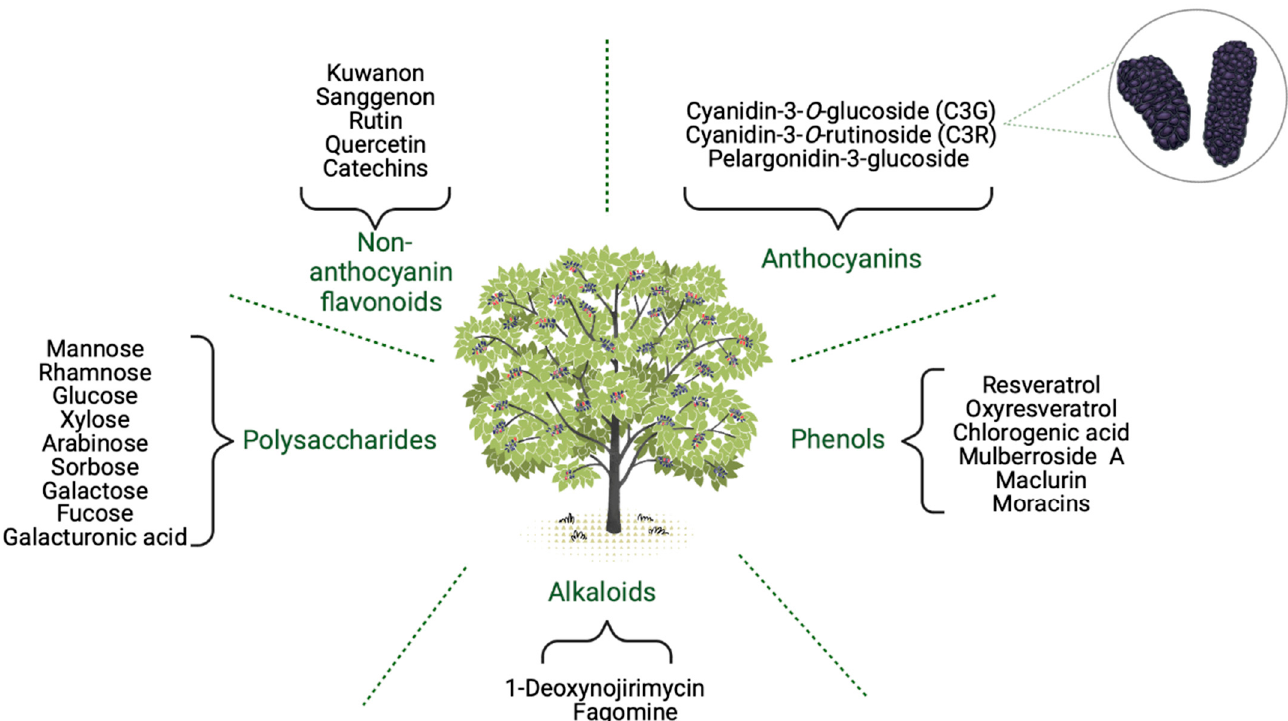
Figure 3. Main bioactive compounds in the mulberry (Created with BioRender.com, accessed on 23 November 2022).